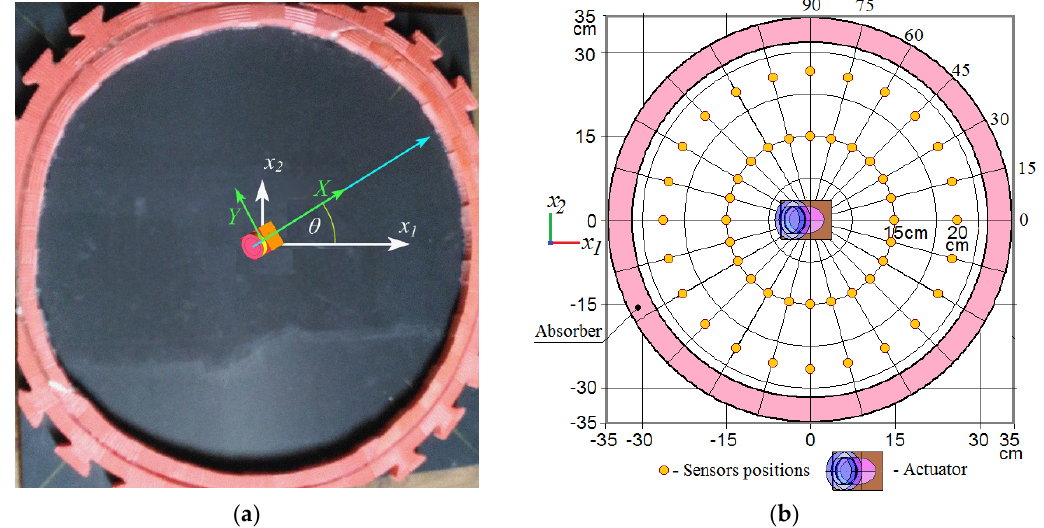
Figure 7. The experimentally studied CFRP panel with schematically shown coordinate systems of orthotropic symmetry ( x 1 , x 2 ) and wedge actuator’s (X,Y) rotated relative to the first one by an angle, θ ( a ); the arrangement of sensors for recording the A0 Lamb waves propagation ( b ).